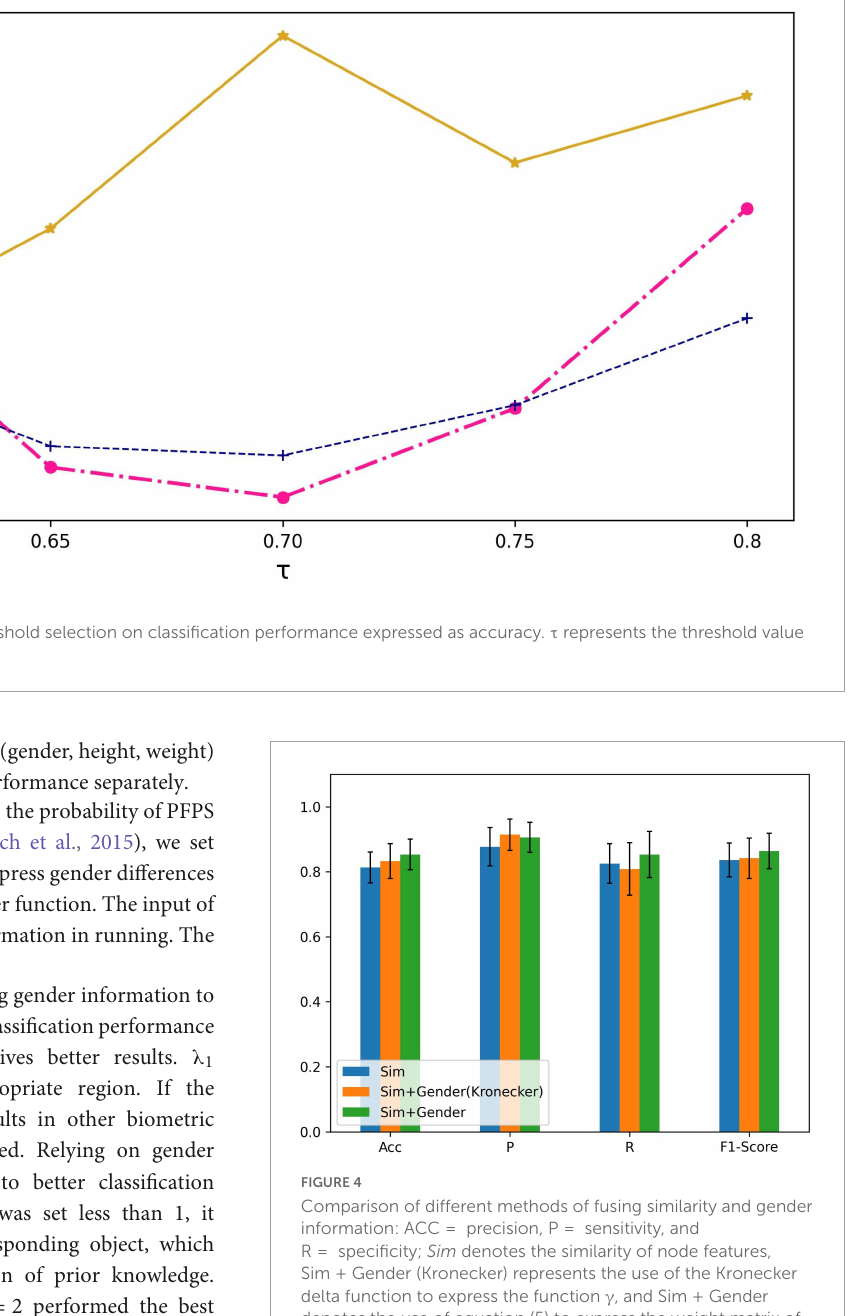
FIGURE4 Comparison of different methods of fusing similarity and gender information: ACC = precision, P = sensitivity, and R = specificity; Sim denotes the similarity of node features, Sim + Gender (Kronecker) represents the use of the Kronecker delta function to express the function γ , and Sim + Gender denotes the use of equation (5) to express the weight matrix of the